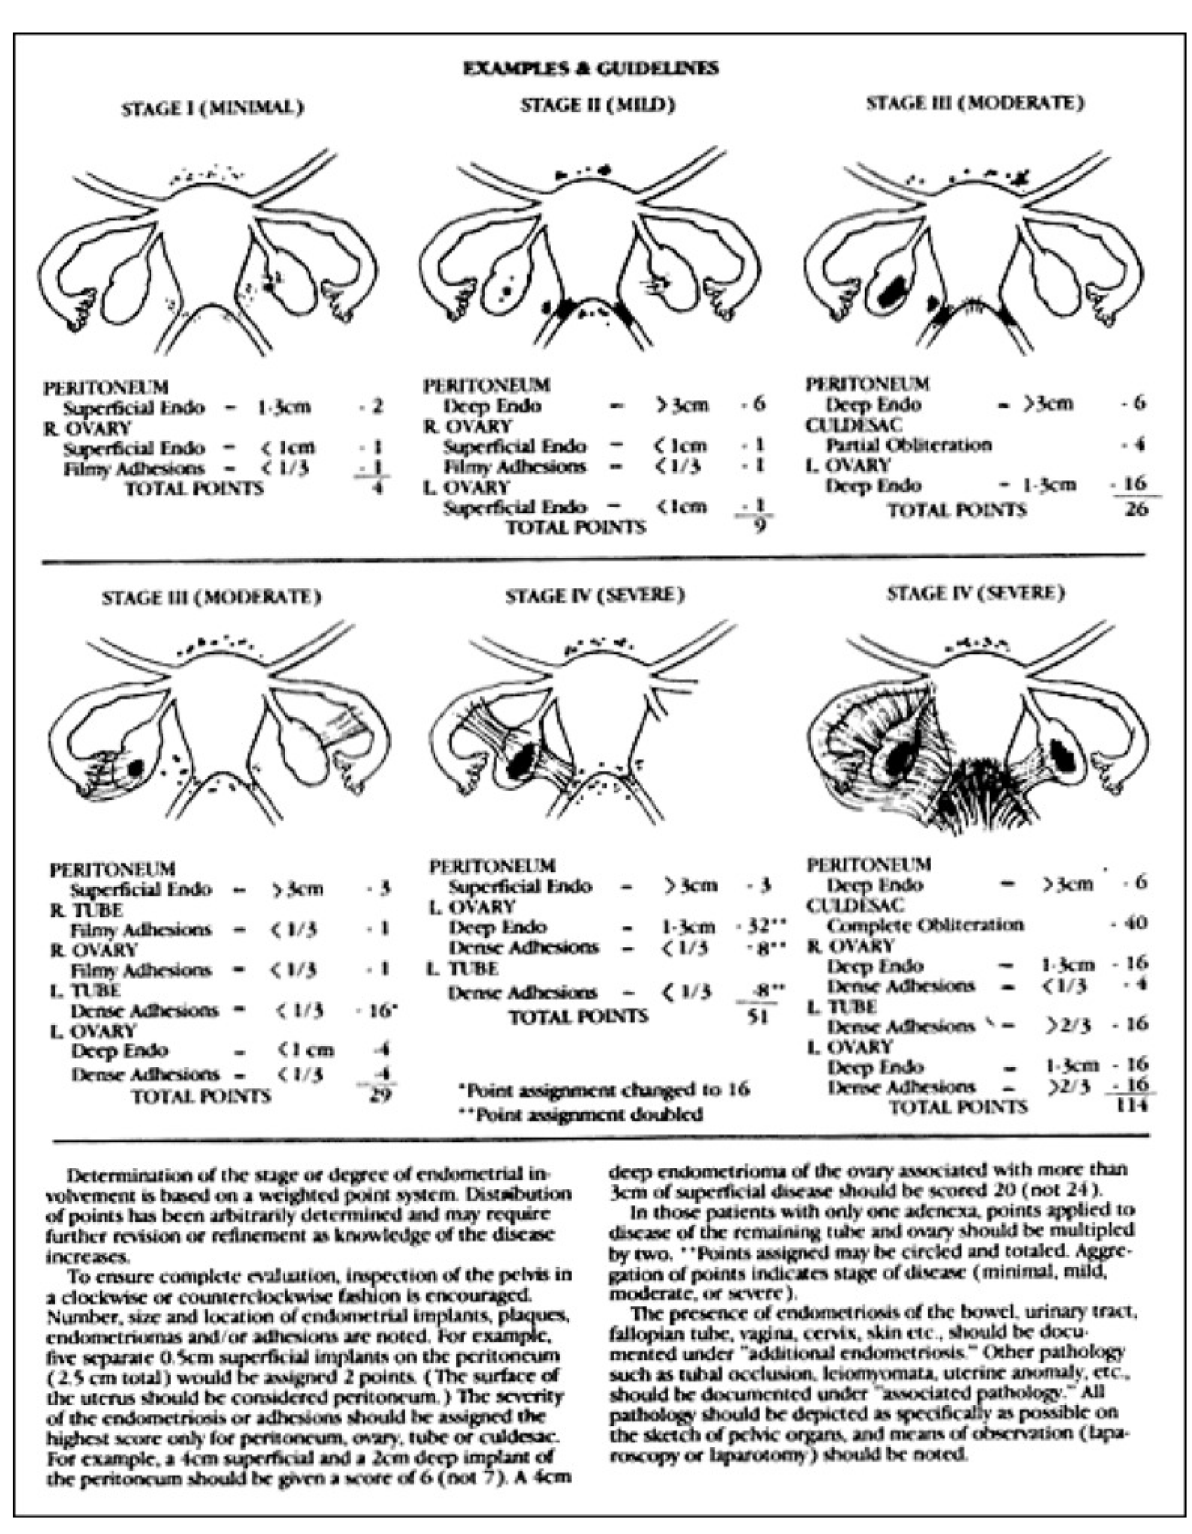
Figure 2. American Society for Reproductive Medicine revised